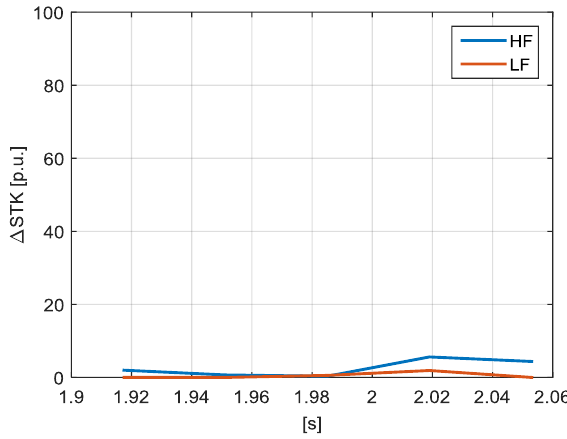
Figure 39. Case study 3: Δ STK at low-frequency (0 ÷ 2.4 kHz, red line) and at high-frequency (2.4 ÷ 150 kHz, blue line) obtained through STFT. Energies 2017 , 10 , 1633 28 of 39